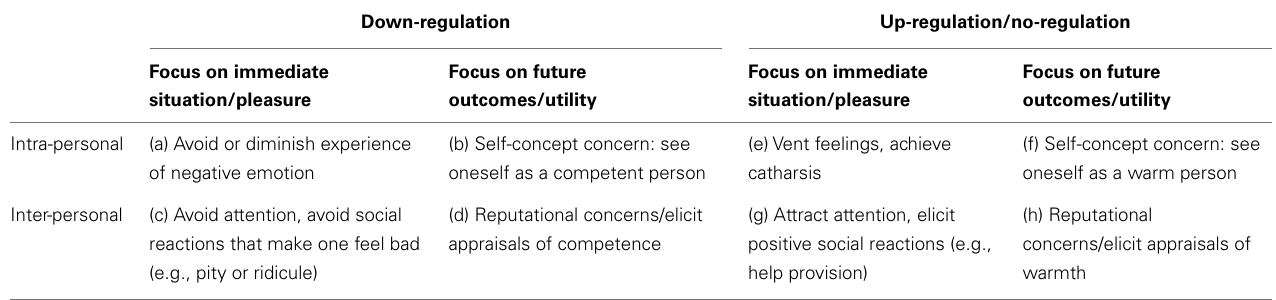
Table 1 | Examples of motives for intra- and inter-personal regulation of crying classified according to their dependence on the pleasure or utility motive.